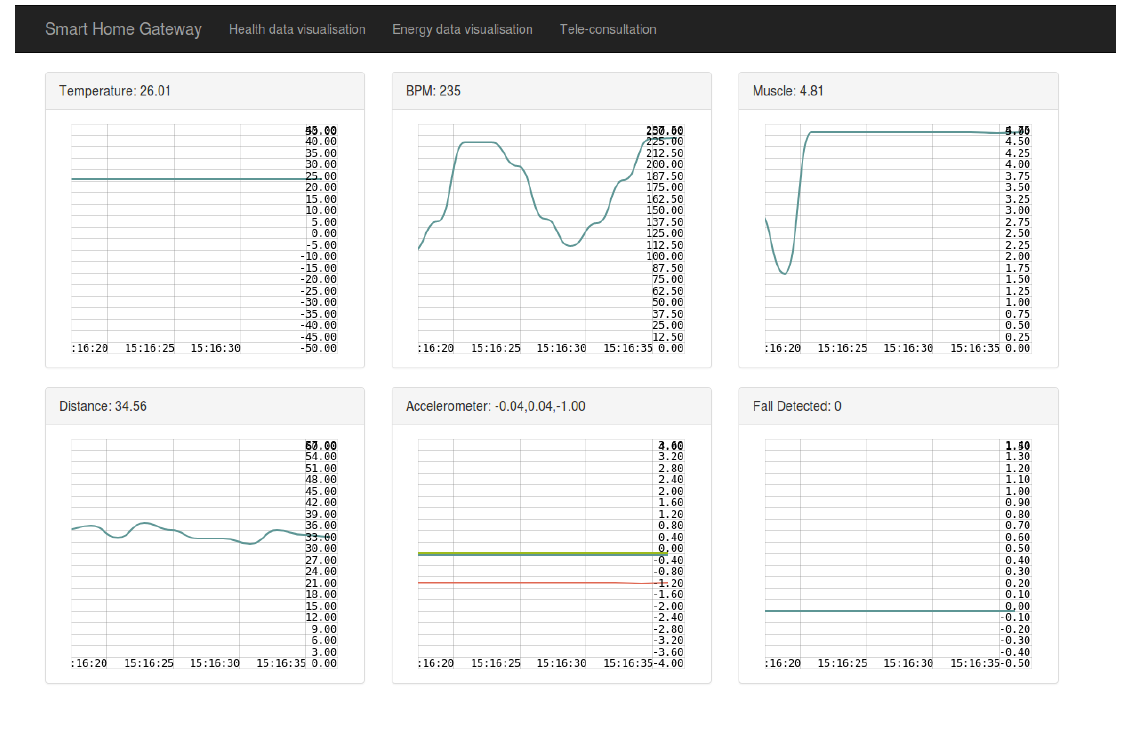
Figure 12. Health data